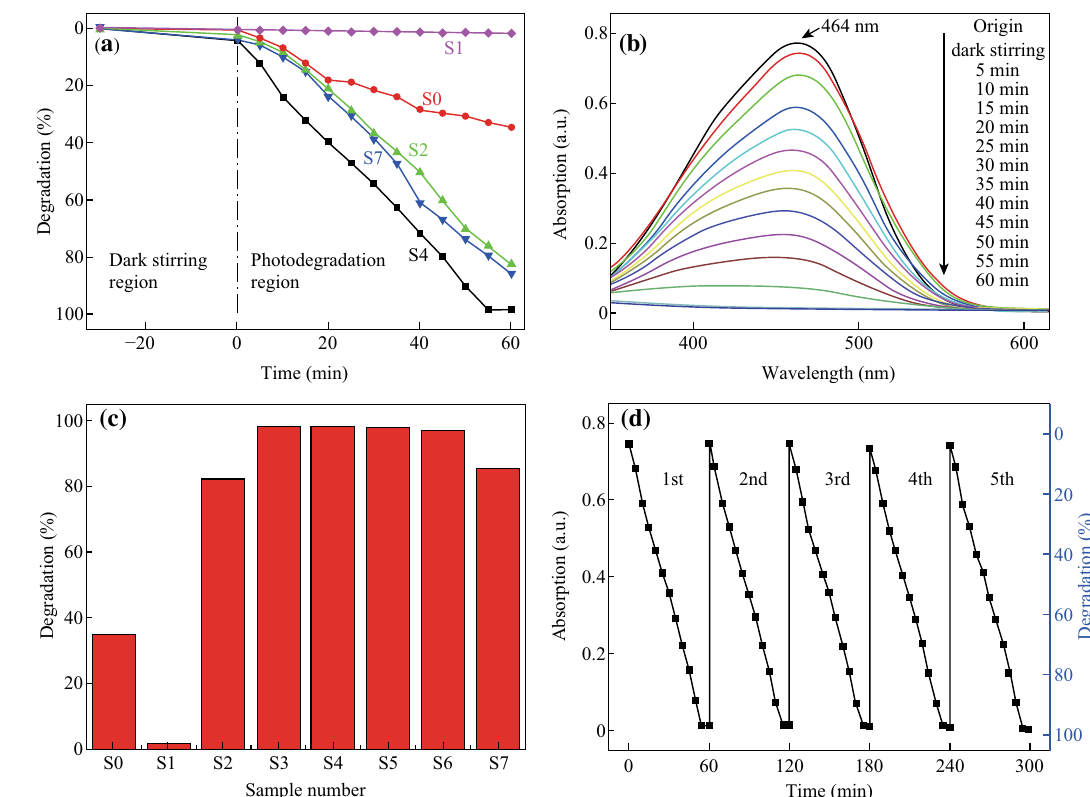
Fig. 6 a Comparisons of degradation rate with different samples in different stages; b absorption spectrums of the degradation with sample S4 in different stages; c comparisons of photocatalytic activities among the Ag–AgCl@TiO 2 NPAS samples with different R under the visible light irradiation and TiO 2 NPAS (S0) sample under the simulated sunlight irradiation in 60 min; d The result of the repeated experiments for five times with sample